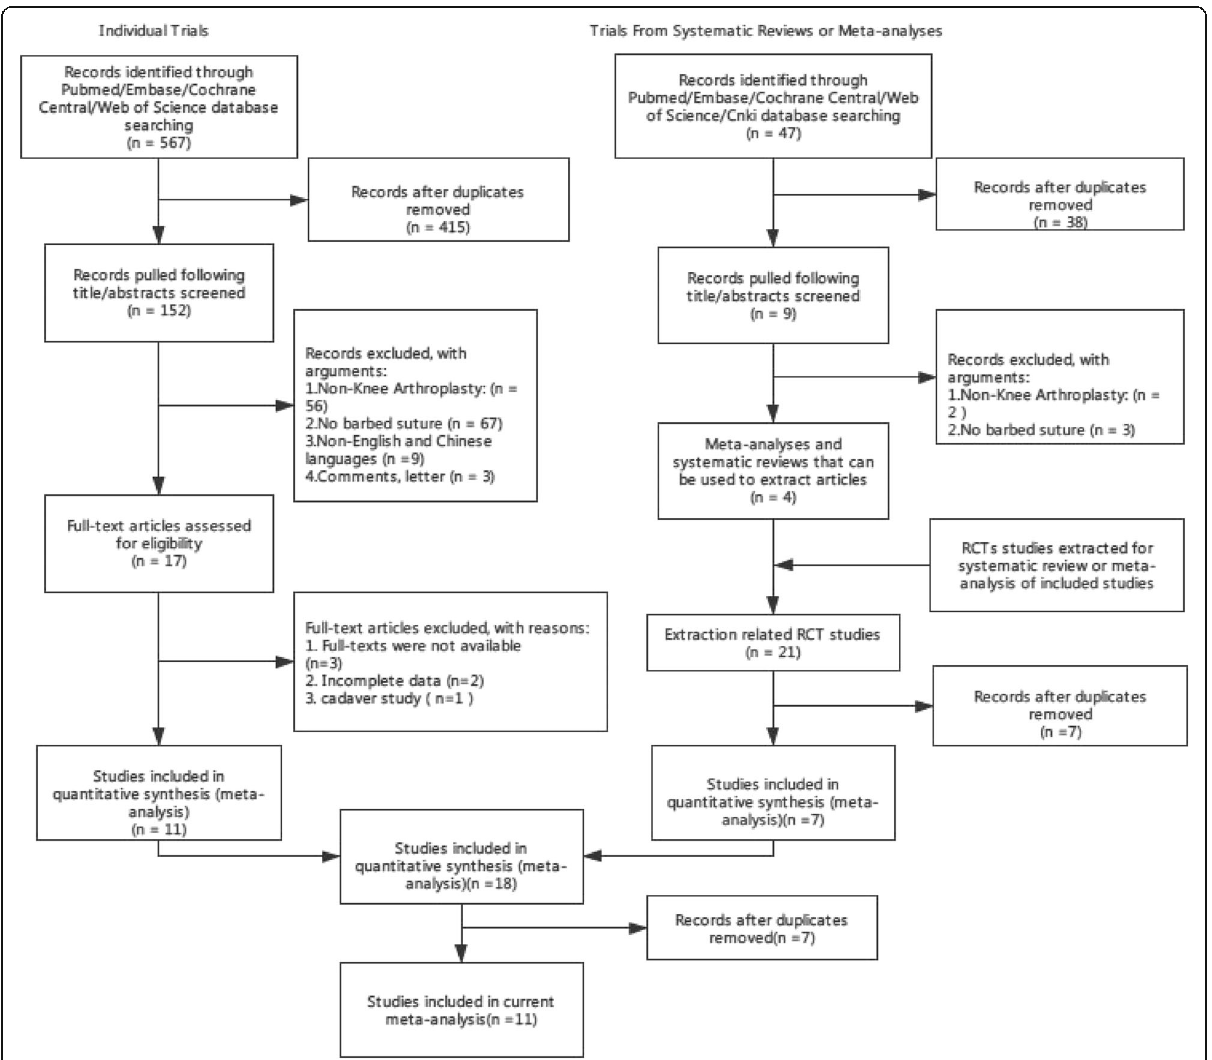
Fig. 1 Flow chart of search